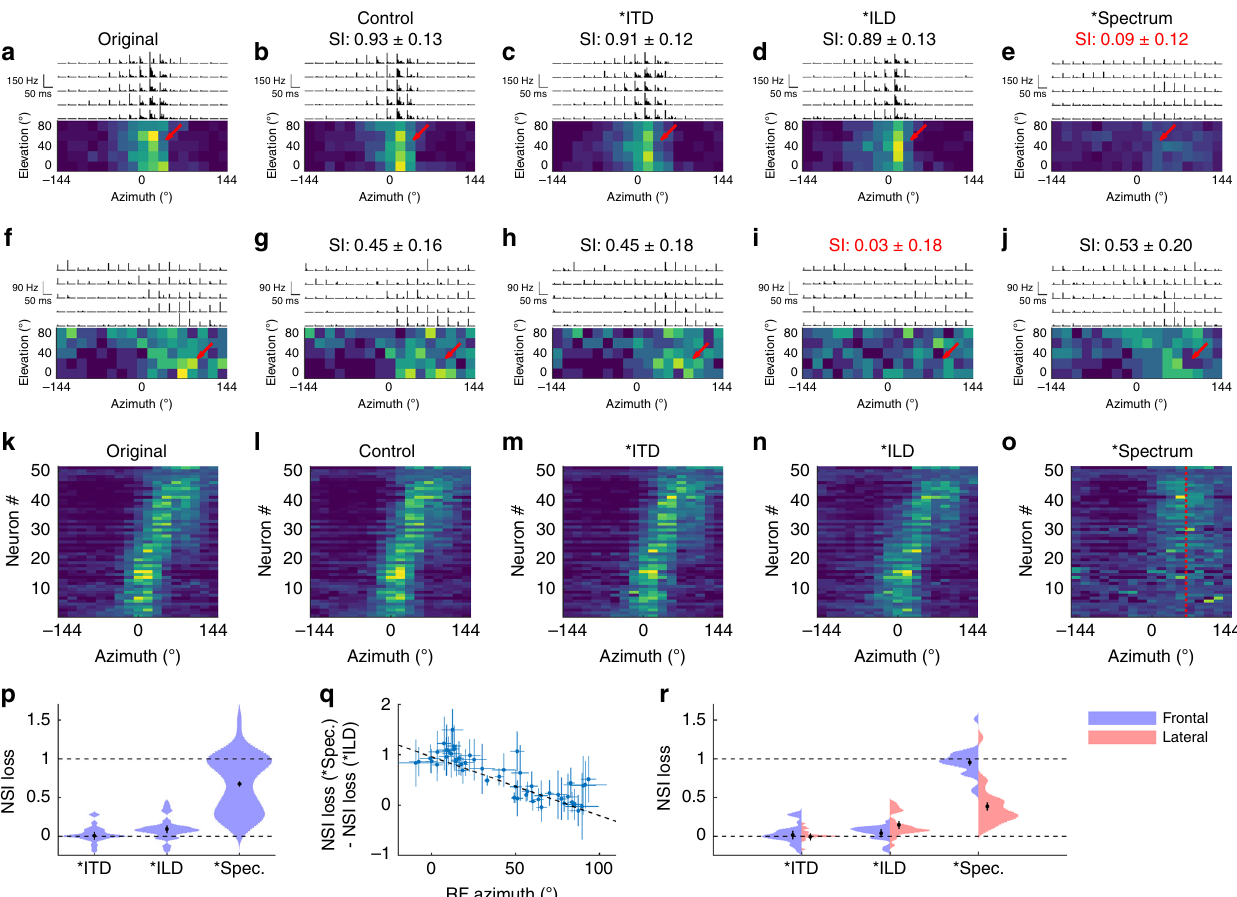
Fig. 3 Structural changes of auditory RFs due to interaural timing difference (ITD), interaural level difference (ILD), and spectral-cue freezing. a – e RFs of a single neuron in response to the a original, b control, c frozen ITD, d frozen average ILD, and e frozen spectrum stimuli. An asterisk (*) indicates that the corresponding cue is frozen. b – e indicate the similarity index (SI; see text). This neuron ’ s RF structure did not change during ITD and ILD freezing, but it disappears with spectrum freezing (red arrow). f – j Example responses from another neuron whose RF disappears with ILD freezing (red arrow). k – o Summary of the horizontal RFs of all 51 neurons that had a reproducible RF. For each neuron, the scale of the responses is normalized by dividing by the sum of responses across all directions. The range of the color scale is from 0 to 0.3. The neurons are sorted by their tuned azimuth. Little changes in the RFs are observed with ITD and ILD freezing ( m , n ), but a dramatic change of the RF structure was observed with spectrum freezing ( o ). With spectrum freezing, all the RF centers become close to 65° azimuth where the ILD is maximized (red dotted line). p Summary of normalized similarity index (NSI) losses in the cue freezing experiments. A large NSI loss is observed with spectrum freezing, consistent with m – o . Source data are provided as a Source Data fi le. q A scatter plot of the RF azimuths and the differences between spectral-cue and ILD NSI losses. As the RF azimuth increases, neurons depend less on spectral cues and more on ILDs ( r = − 0.83). The errors in X -axis are derived from the Kent distribution fi ts; the errors in Y -axis are based on the Poisson statistics and arithmetic propagation (see Methods). r Comparison of the average NSI loss for frontal and lateral RFs. Neurons with frontal rather than lateral RFs depend almost entirely on spectral cues. Source data are provided as a Source Data fi